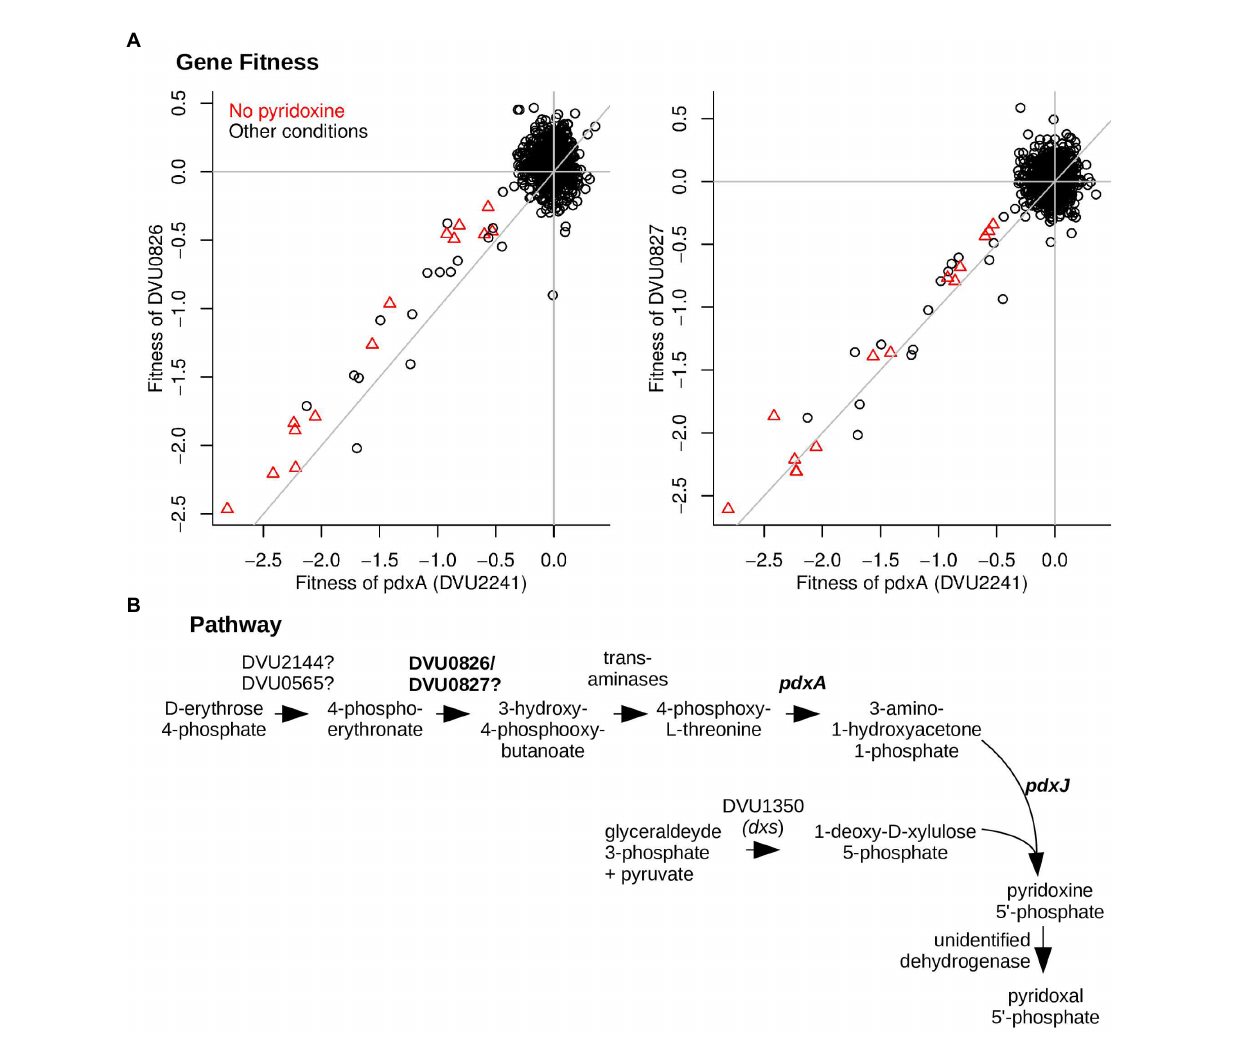
FIGURE 4 DVU0826 and DVU0827 are required for vitamin B 6 synthesis. (A) Comparison of gene fitness values across 757 experiments between pdxA (DVU2241) and either DVU0826 (left) or DVU0827 (right). Experiments performed in the absence of pyridoxine are highlighted. pdxA has high cofitness with both DVU0826 ( r = 0.81) and DVU0827 ( r = 0.84). (B) The proposed pathway of pyridoxal phosphate biosynthesis in